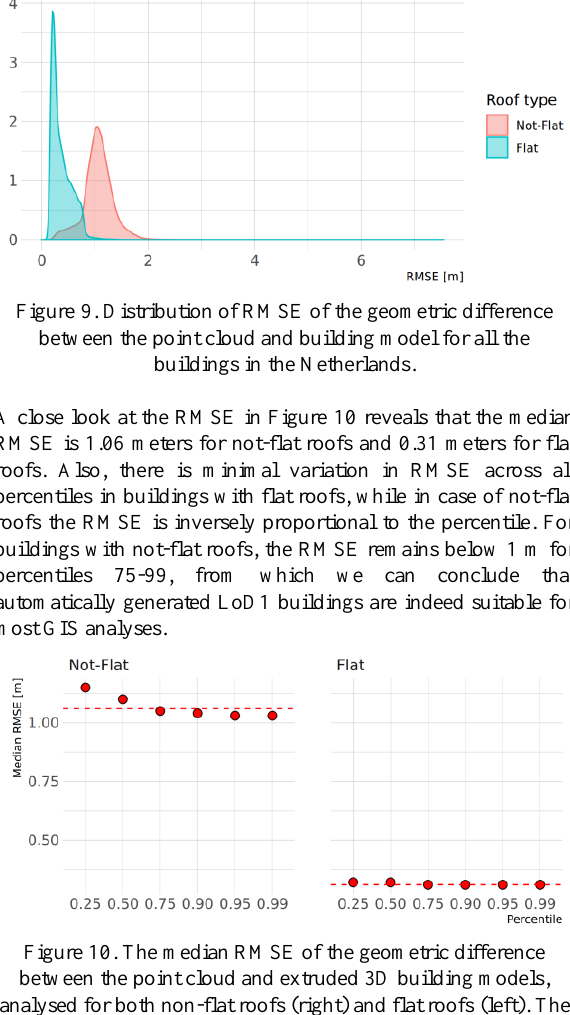
Figure 11. Median building height in municipalities of the Netherlands: Left for non-flat roofs and right for flat roofs. Each dot represents a municipality. The building height is calculated as the distance between the ground and the model height at 95th